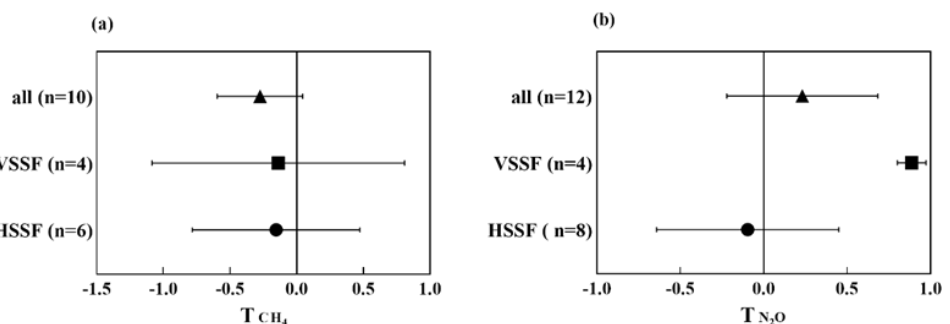
Figure 2. Effect on T index of CH 4 ( a ) and N 2 O ( b ) emission from different CW types compared to FWS CWs. The n throughout the manuscript refers to samples used in the analysis and the error bars are 95% CIs.